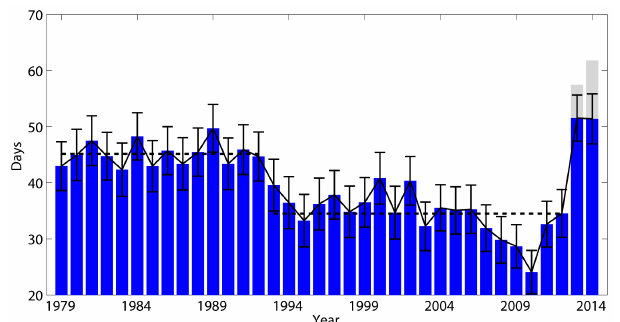
Figure 2. Variation in WHD NCP from 1979 to 2014 (units: days); the error bar represents 1 standard error among the measured sites. For 2013–2014, the thresholds of 7.5km (blue) and 10km (gray) are both shown, and the dashed lines indicate the mean values for 1979–1992 and 1993–2012, respectively.